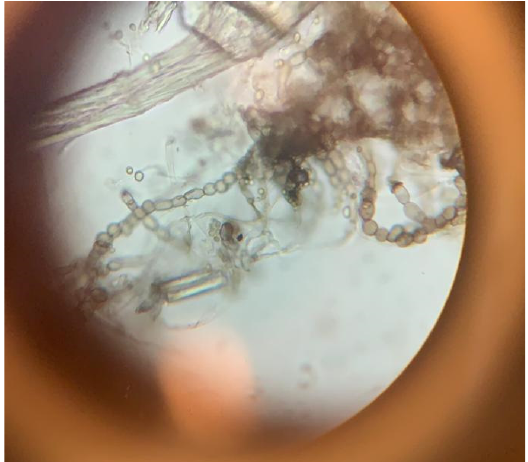
Figure 10. Aureobasidium mold sample A1 in a microscope.